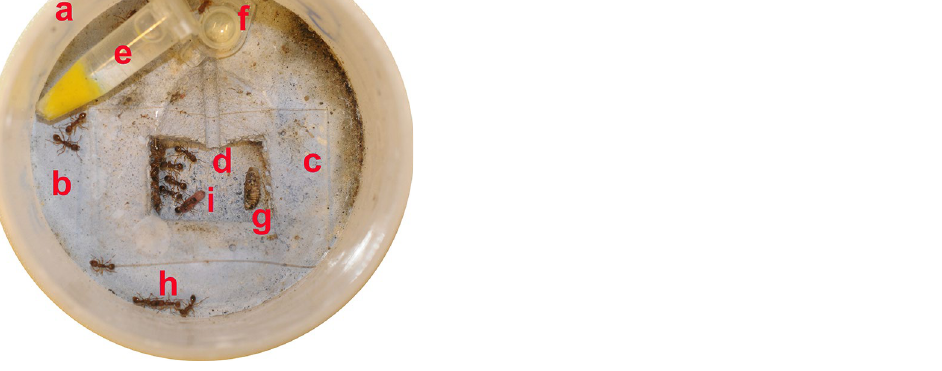
Figure 3. Nest design. ( a ) Plastic box. ( b ) Plaster floor. ( c ) Glass plate. ( d ) Nest chamber with entrance. ( e ) “Drinker” (a 1.5 mL Eppendorf tube with cut tip, stuffed with a piece of cloth and filled with tap water). ( f ) Honey-sugar water in a “feeder” (the cap of an 1.5 mL Eppendorf tube). ( g ) Insect food (dead cockroach). ( h ) Myrmica scabrinodis workers. ( i ) Young Phengaris alcon caterpillar with a M. scabrinodis worker. The diameter of the nest is 60 mm. Photo: Ferenc